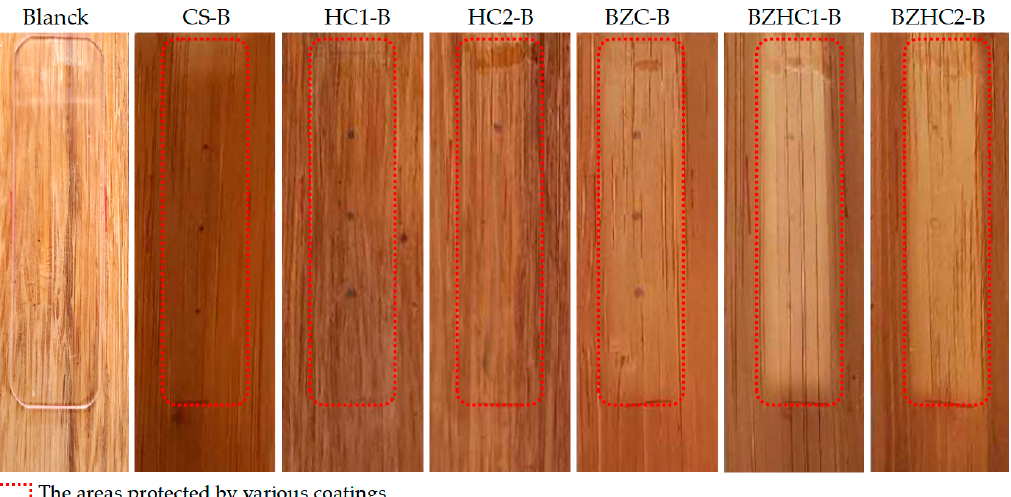
Figure 4. The pictures of Blank sample without exposure and weathered samples (300 h of exposure).